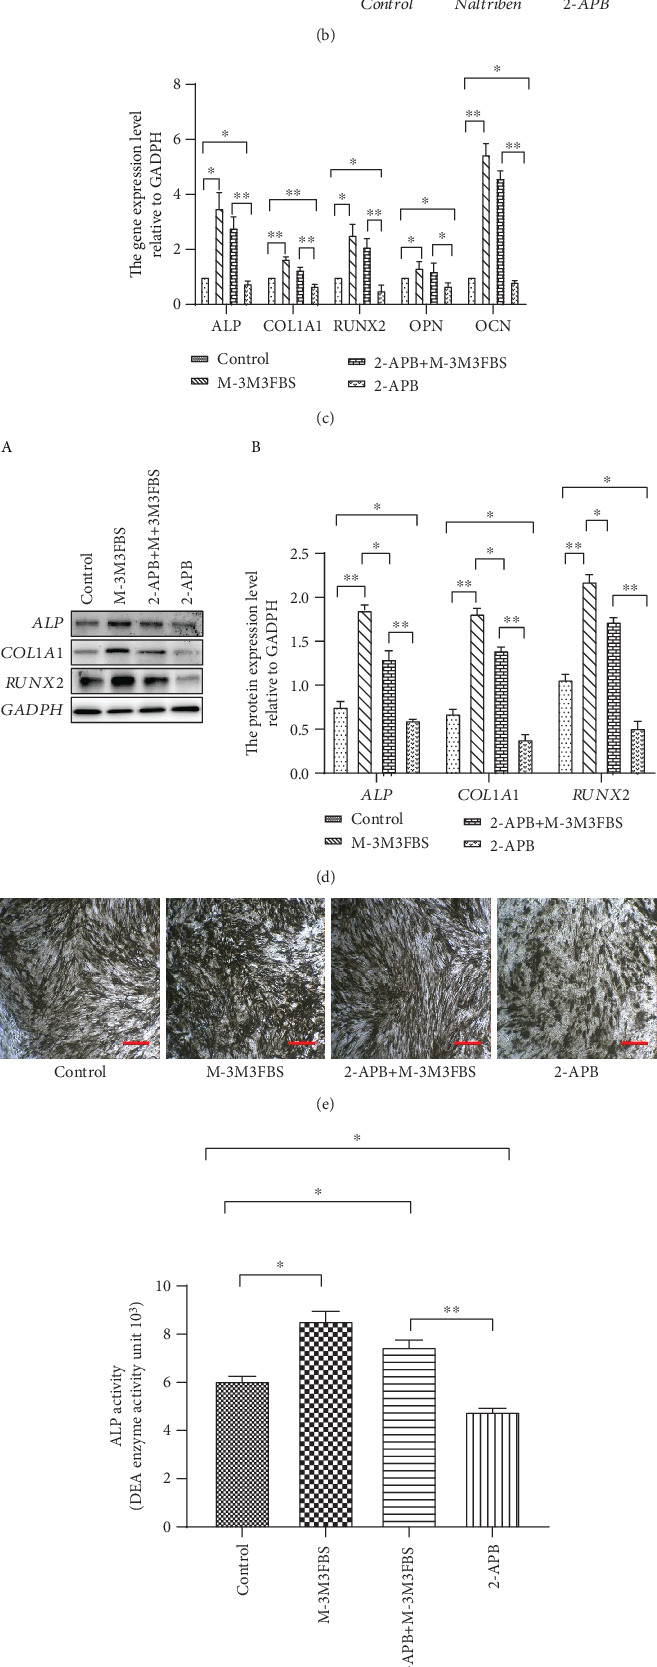
The expression of osteogenic markers and the osteogenic potential of hBMSCs under inhibiting TRPM7 and activating PLC (HSPG2). (a) (A) Western blot analysis of PLC activity in cells induced with osteogenic medium or osteogenic medium plus control shRNA or TRPM7 shRNA induced for 14 days. (B) The relative activity of PLC protein was quantified and plotted. (b) (A) Western blot analysis of the activity of PLC in cells induced with osteogenic medium or osteogenic medium plus Naltriben or 2-APB induced for 14 days. (B) The relative activity of PLC protein was quantified and plotted. Control shRNA: hBMSCs transfected with negative control-shRNA-vector; TRPM7 shRNA: hBMSCs transfected with TRPM7-shRNA-vector. (c) RT-PCR analysis of osteogenic markers ALP, COL1A1, RUNX2, OPN, and OCN in cells induced with osteogenic medium supplemented with different pharmaceuticals induced for 14 days. (d) (A) Western blot analysis of osteogenic marker proteins ALP, COL1A1, and RUNX2 in cells induced with osteogenic medium supplemented with different pharmaceuticals induced for 14 days. (B) The relative levels of osteogenic marker proteins were quantified and plotted. (e) Analysis of ALP staining in cells induced with osteogenic medium supplemented with different pharmaceuticals induced for 14 days. (f) Analysis of ALP activity (the unit for p-nitrophenyl: μmol) in cells induced with osteogenic medium supplemented with different pharmaceuticals induced for 14 days. (g) Staining of ARS in cells induced with osteogenic medium supplemented with different pharmaceuticals induced for 14 days. (h) A quantification of ARS in cells induced with osteogenic medium supplemented with different pharmaceuticals induced for 14 days. Scale: 200 μm. Control: cells induced in osteogenic medium without any pharmacological treatment; M-3M3FBS: cells induced in osteogenic medium supplemented with 20 μM M-3M3FBS; 2-APB+M-3M3FBS: cells induced in osteogenic medium supplemented with 50 μM 2-APB and 20 μM/mL M-3M3FBS; 2-APB: cells induced in osteogenic medium supplemented with 50 μM 2-APB. ∗P < 0.05, ∗∗P < 0.01, and ∗∗∗P < 0.0001.